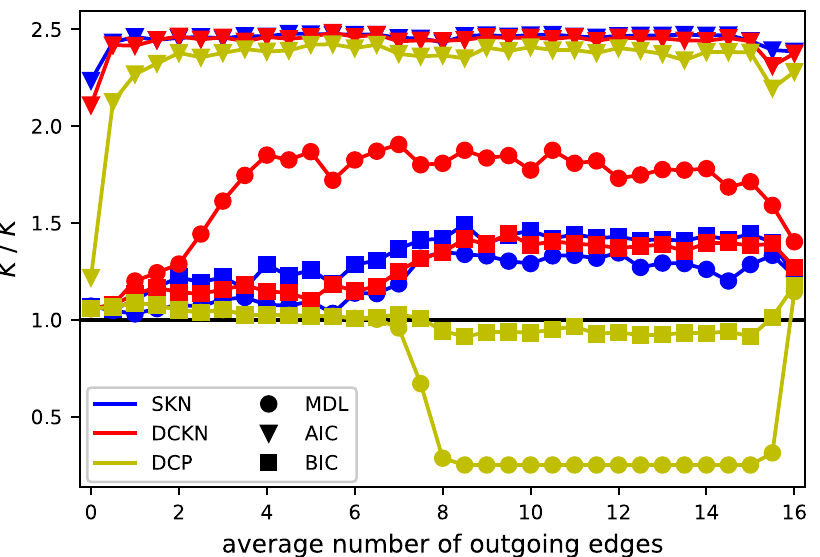
Fig 9. Ratio of average selected number of blocks � K to true number of blocks K of the classic SBM variants with the presented model selections. As in Fig 10, the values shown are based on the same setting as Fig 8.